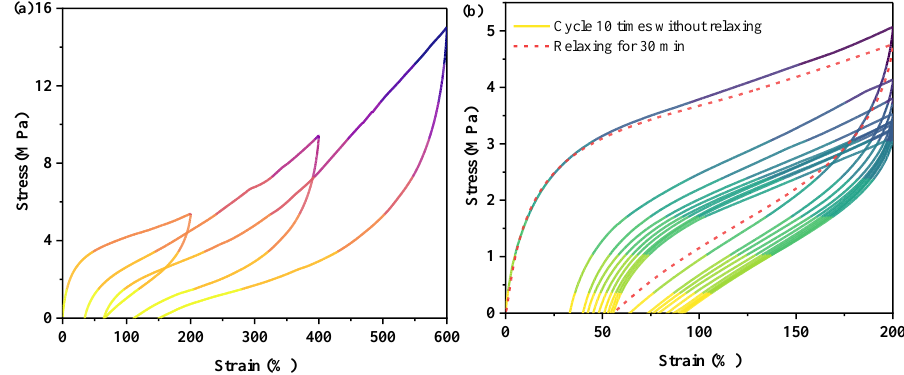
Figure 6. Continuous cyclic tensile curves of ZPU ( a ) At various strains without relaxing, ( b ) At 200% strain without relaxing and then relaxing for 30 min.